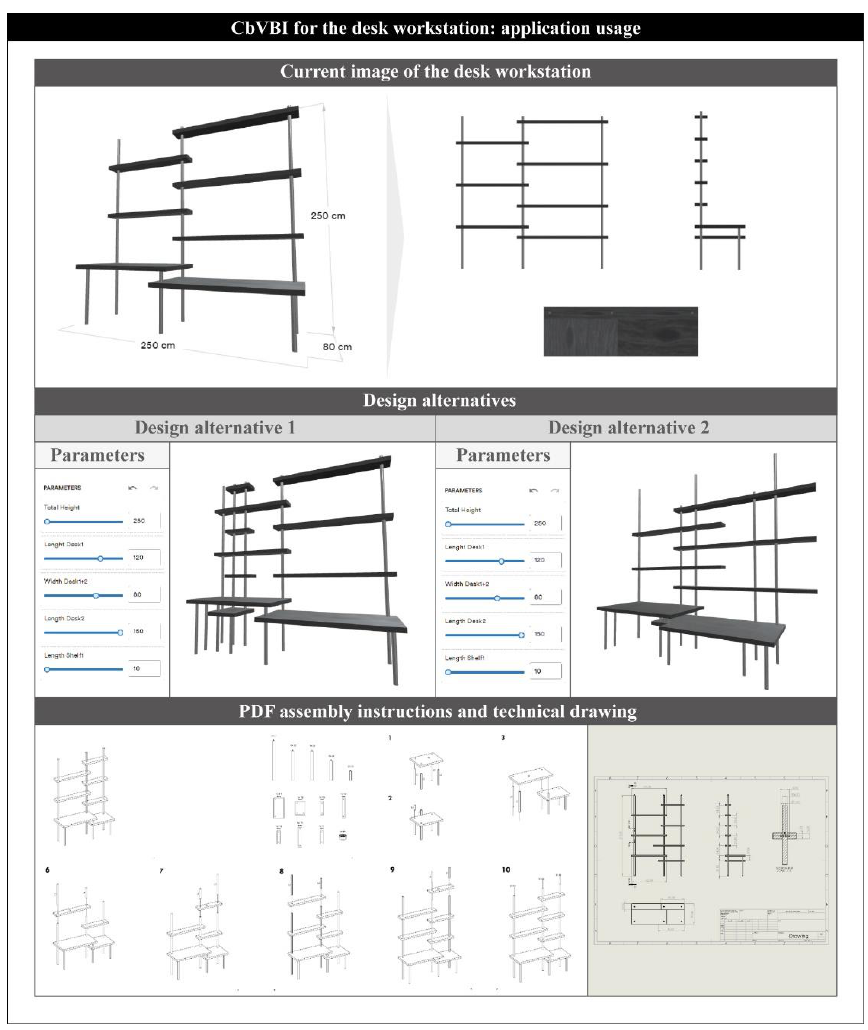
Figure 12. Desk workstation design alternatives and export files.